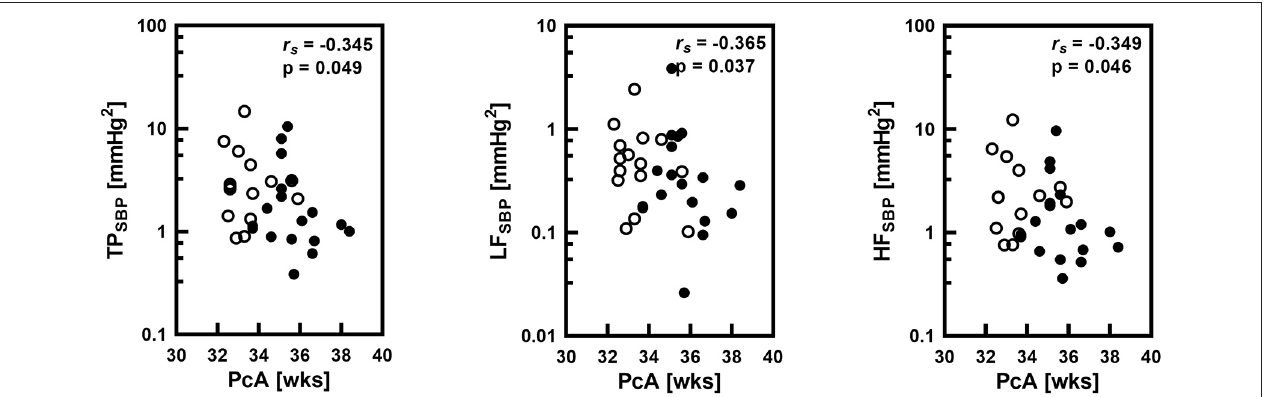
FIGURE 2 | Correlations between postconceptional age (PcA) in weeks (wks) and spectral total power (TP), low frequency band spectral power (LF) and high frequency band spectral power (HF) of systolic blood pressure (SBP) variability with the Spearman correlation coefficient (r s ) and statistical significance level (P). Logarithmic scale was applied on y-axis. Empty circles corresponds to infants with gestational age below 32